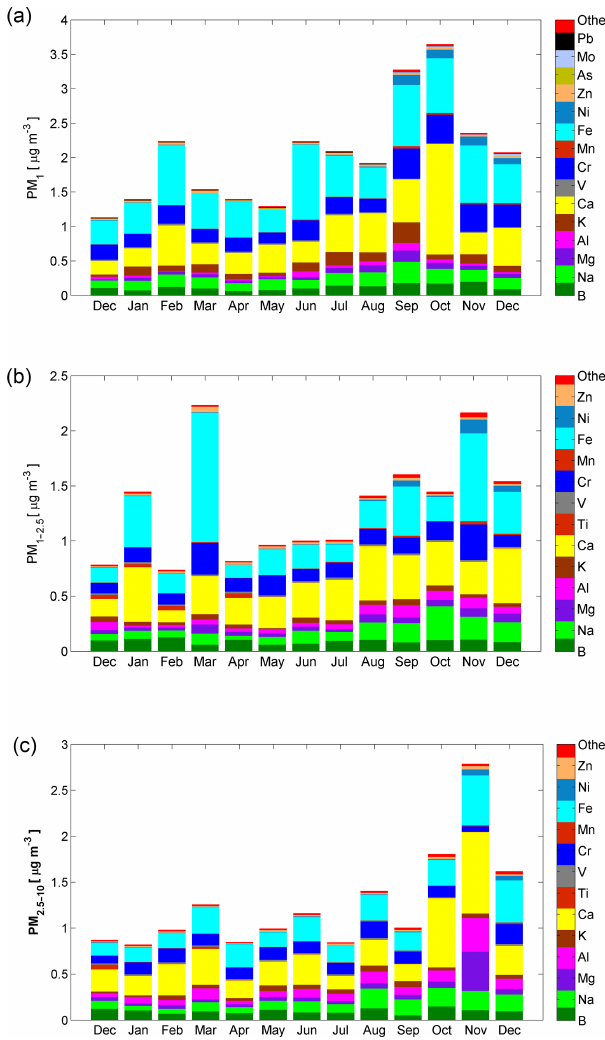
Figure 4. The monthly median trace metal concentrations in the PM 1 (a) , PM 1–2 . 5 (b) and PM 2 . 5–10 (c) size fractions.